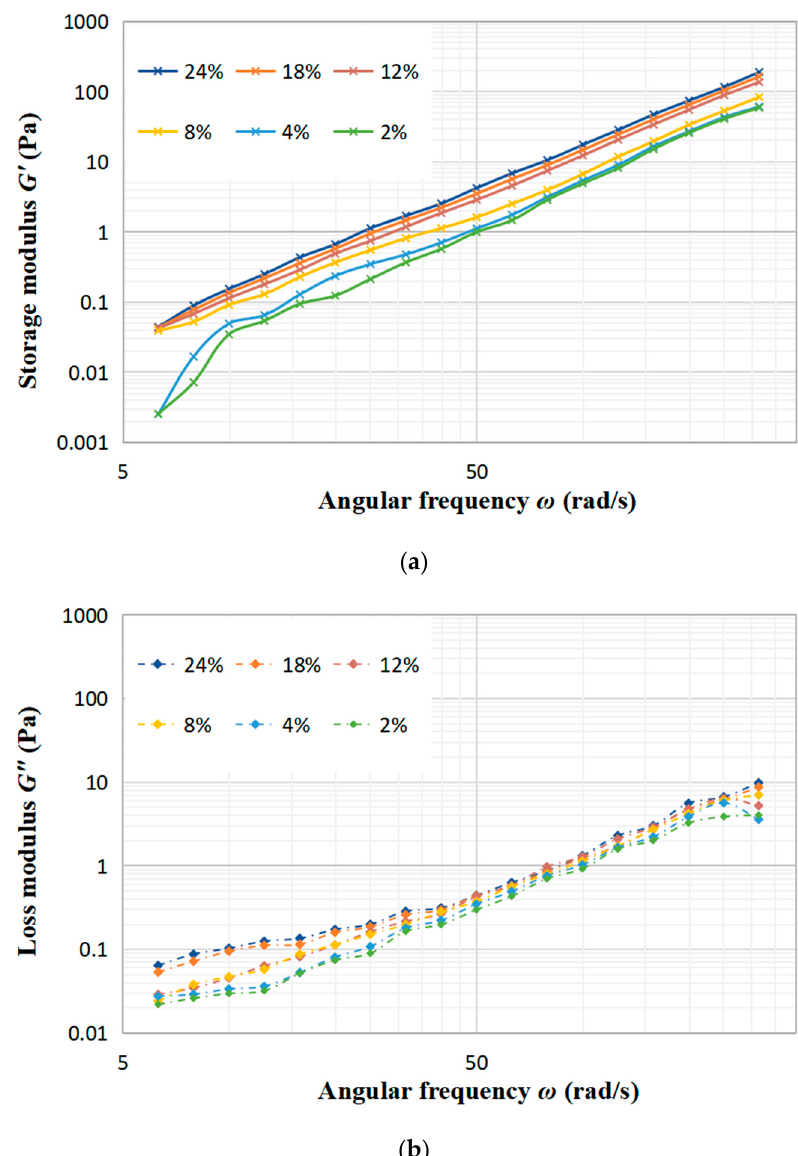
Figure 4. Effect of the angular frequency on the storage modulus G (cid:48) ( a ) and the loss modulus G (cid:48)(cid:48) ( b ) at different concentration of DCF